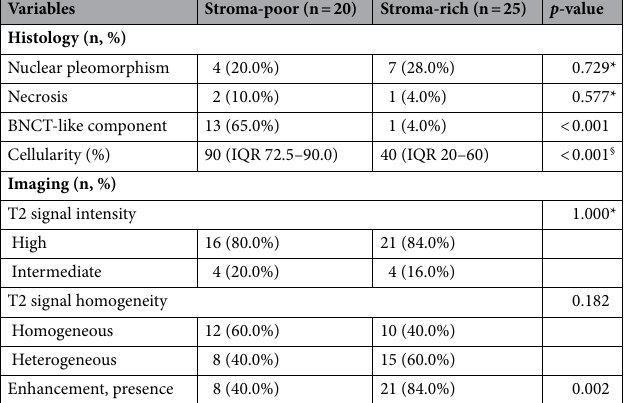
Table 1. Comparison between histomorphologic and radiologic features according to the stromal component of chordomas. BNCT benign notochordal cell tumor, IQR Interquartile range. *Fisher’s exact test. § Mann– Whitney